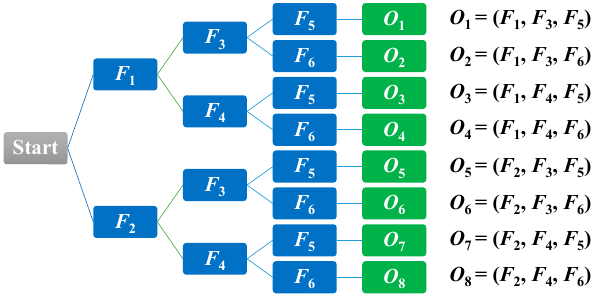
Figure 10. Hierarchical tree structure of independent observable symbol O .